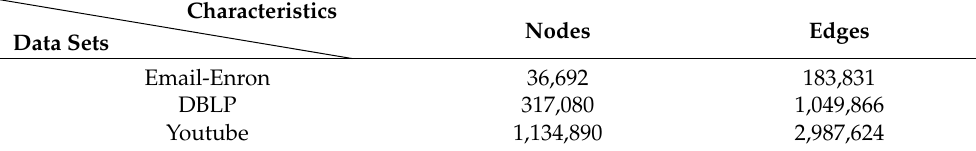
Table 2. Attributes of the benchmark datasets.